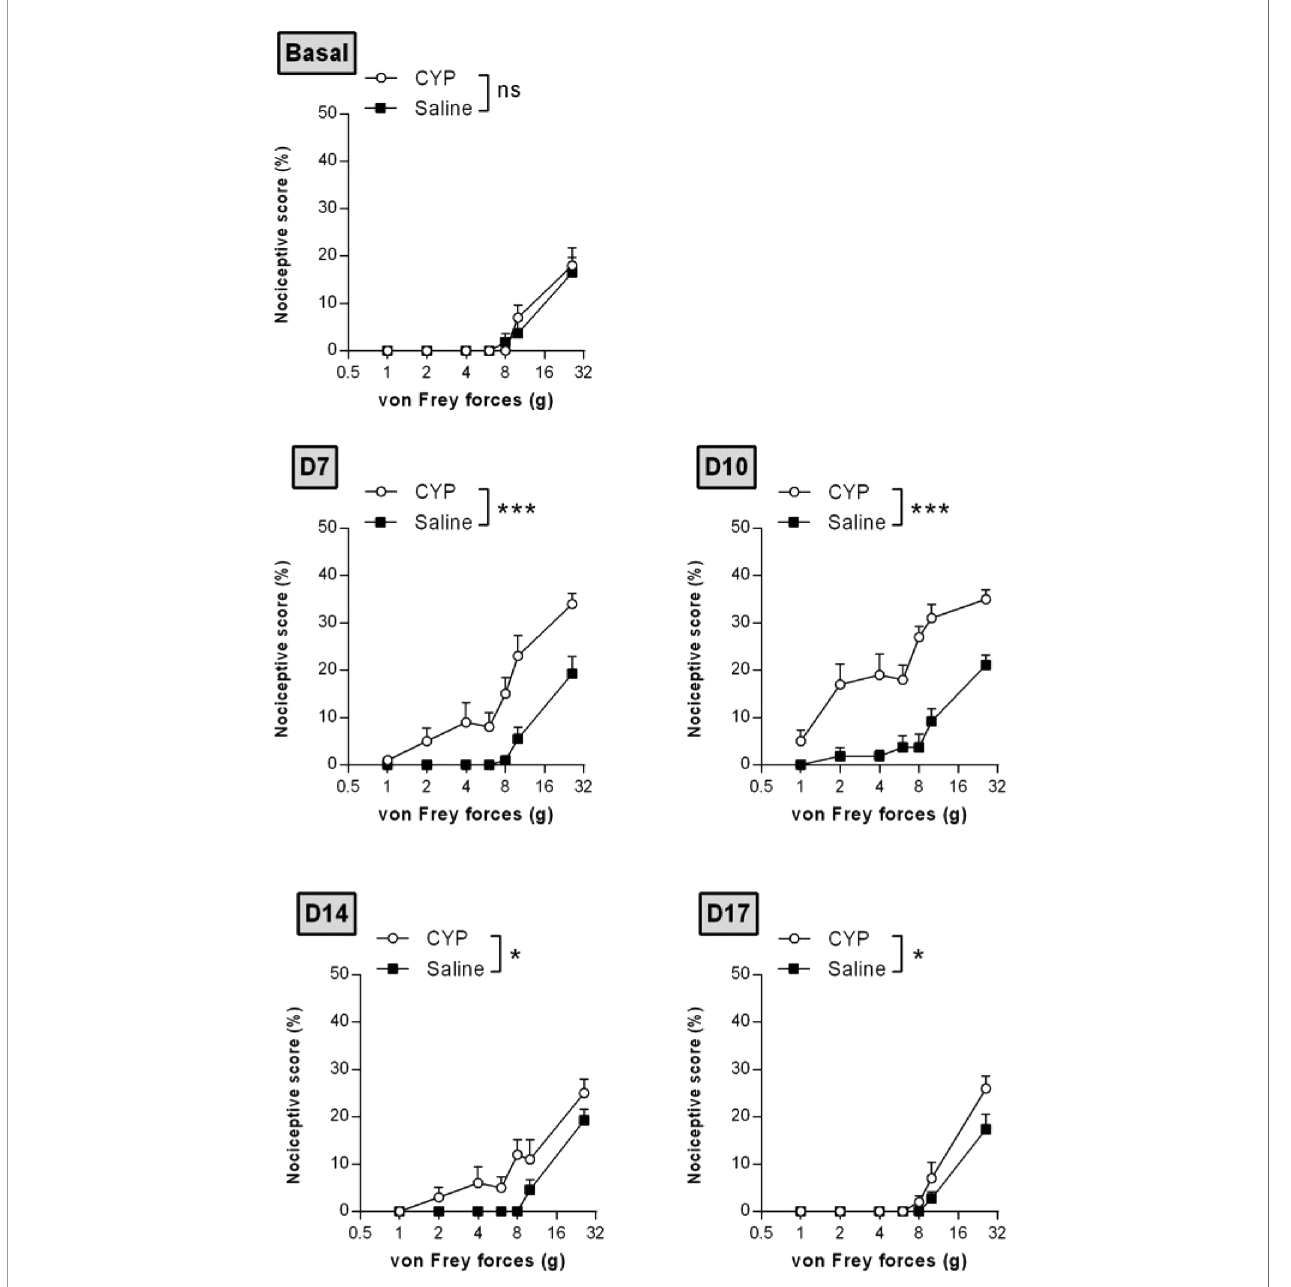
FIGURE 3 | Repeated injections of low dose of CYP induced persistent visceral pain. Rats received three doses of CYP (40 mg/kg, i.p.) or saline (5 ml/kg, i.p.) on days 0, 3, and 6. Nociceptive response was assessed in a time-course study over 17 days by application of von Frey fi laments of increasing force on the vicinity of the urinary bladder. Nociceptive score was expressed as the percentage of the maximal score for each von Frey force. Data represent mean values ± SEM (n =11 and 12 for CYP and Saline, respectively). ns p > 0.05, *p < 0.05, ***p < 0.001 (two-way RM